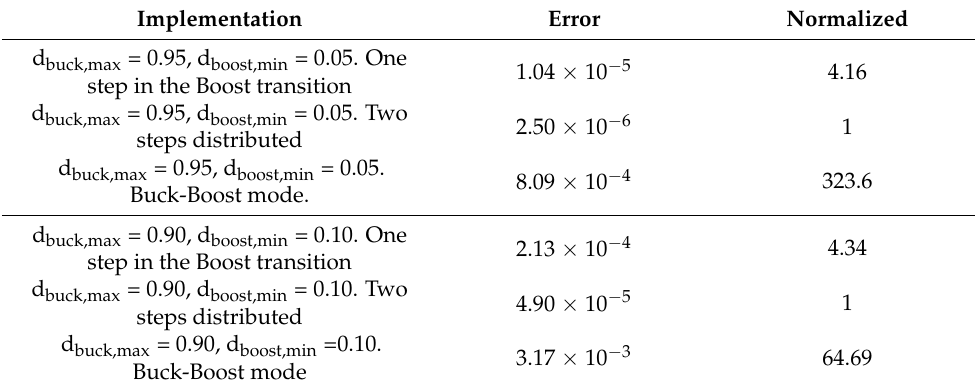
Table 4. Comparison of the conversion ratio obtained with different implementations.